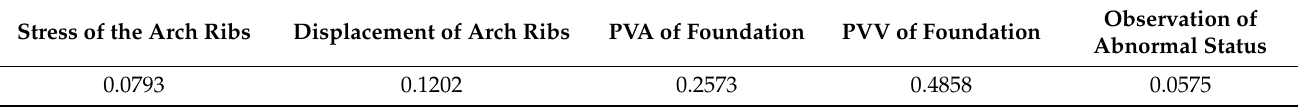
Table 4. Normalized weights of comprehensive assessment during nearby construction.